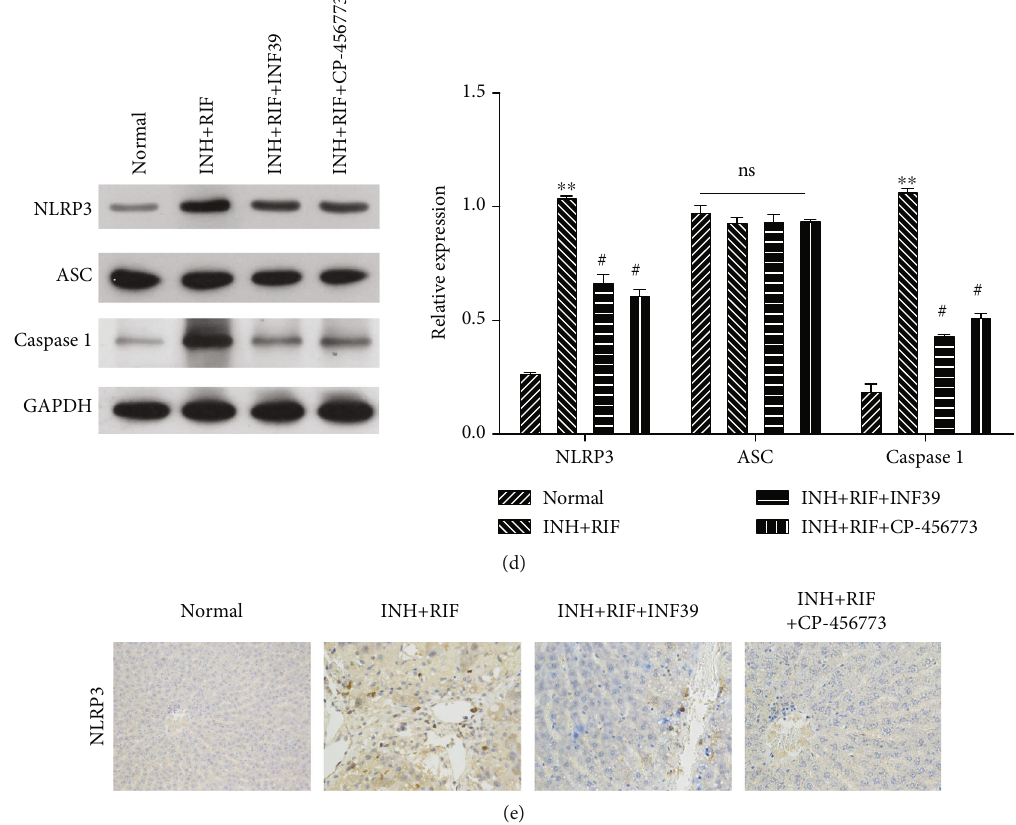
Figure 3: NLRP3 in fl ammasomes were required for INH- and RIF-induced in fl ammatory responses in rats. Rats were treated with INH and RIF for 28 consecutive days and then treated with an NLRP3-in fl ammasome inhibitor (INF39 or CP-456773, respectively). (a – c) ELISA assays were performed to evaluate the e ff ects of NLRP3 inhibitors on INH- and RIF-induced in fl ammatory factors (IL-33, IL-18, and IL- 1 β ) in the serum of each group of rats. (d) The levels of NLRP3, ASC, and cleaved-caspase 1 protein expression were assessed by western blot assays, and the relative levels of the proteins were analyzed based on the gray value. (e) IHC assays revealed the expression and distribution of NLRP3 in the liver tissues of rats in each group. Magni fi cation, × 100. ∗∗ P < 0 : 01 vs. the normal group; # P < 0 : 05 vs. the INH and RIF